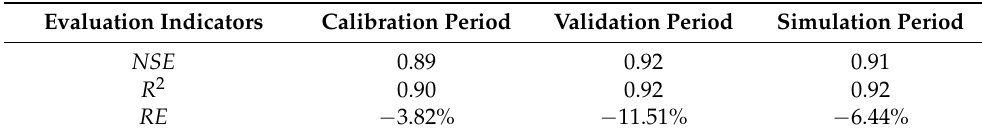
Table 3. Monthly efficiencies for calibration period from 1971 to 1990, validation period from 1991 to 2020 and entire simulation period from 1971 to 2020.